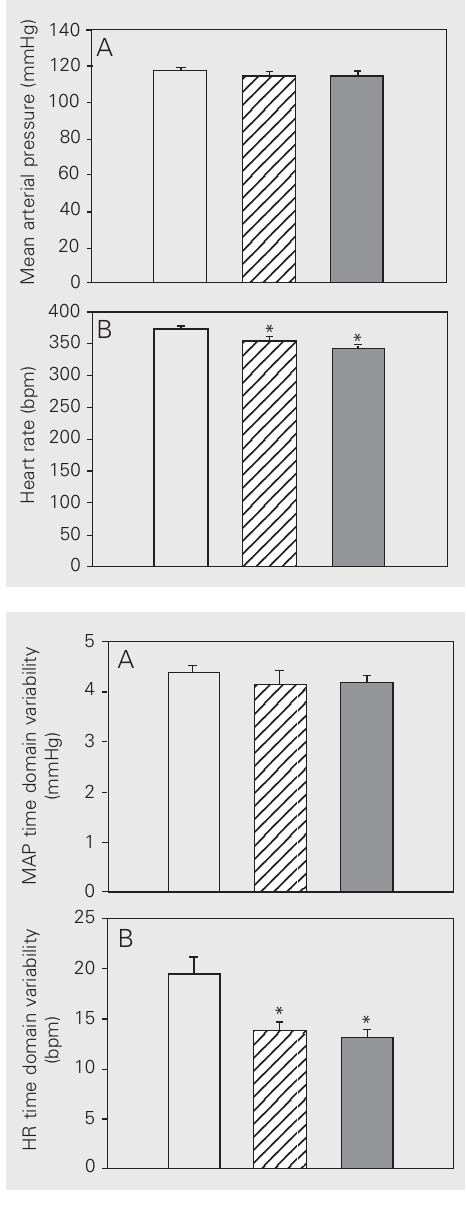
Data are reported as means ± SEM for 8 rats in each group. SIO = serum iron overload; TIO = tissue iron overload.